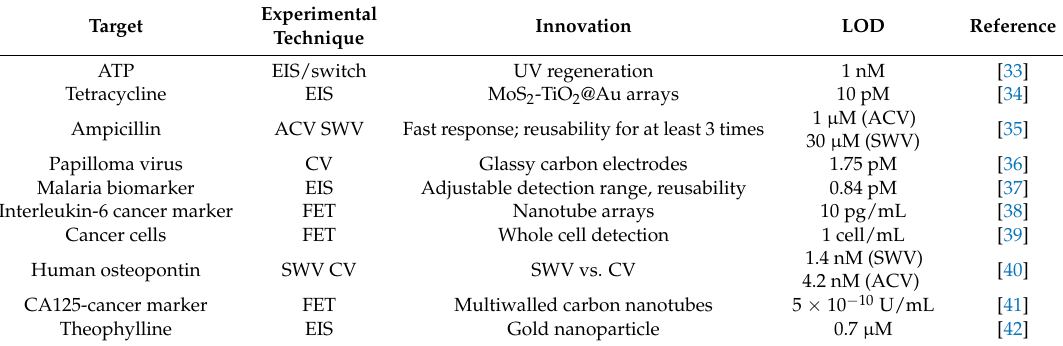
Table 1. Analytical characteristics of electrochemical aptasensors and the scientific innovation of the